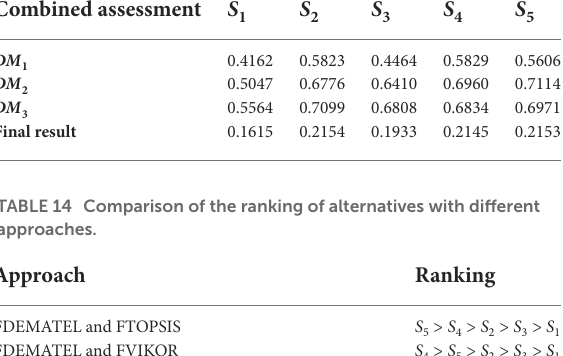
TABLE 13 Combined assessment of five alternatives for three decision makers. Combined assessment